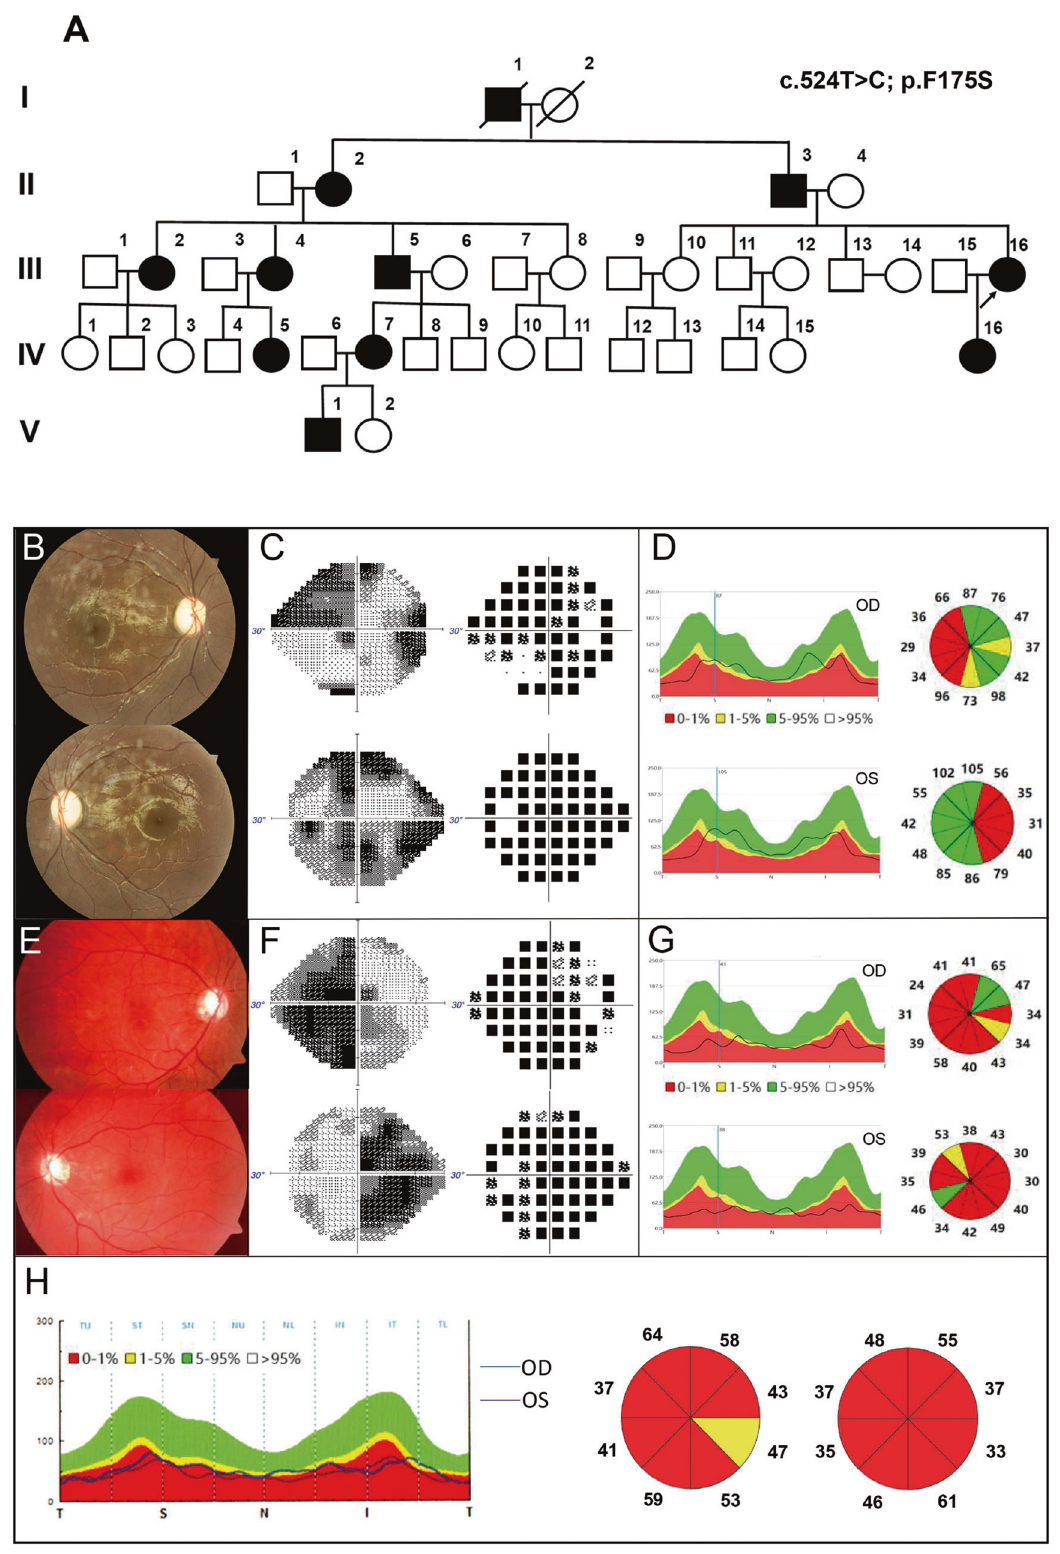
Fig. 1 The pedigree and ophthalmologic examinations of 3 representative patients in the family. A The Pedigree of the large DOA family. B , E Fundus photography showed temporal pallor of the optic disc. C , F Visual fi eld testing presented defect of the visual fi eld. D , G , H SS-OCT exhibited varying degrees of bilateral thinning of RNFL in patients of different